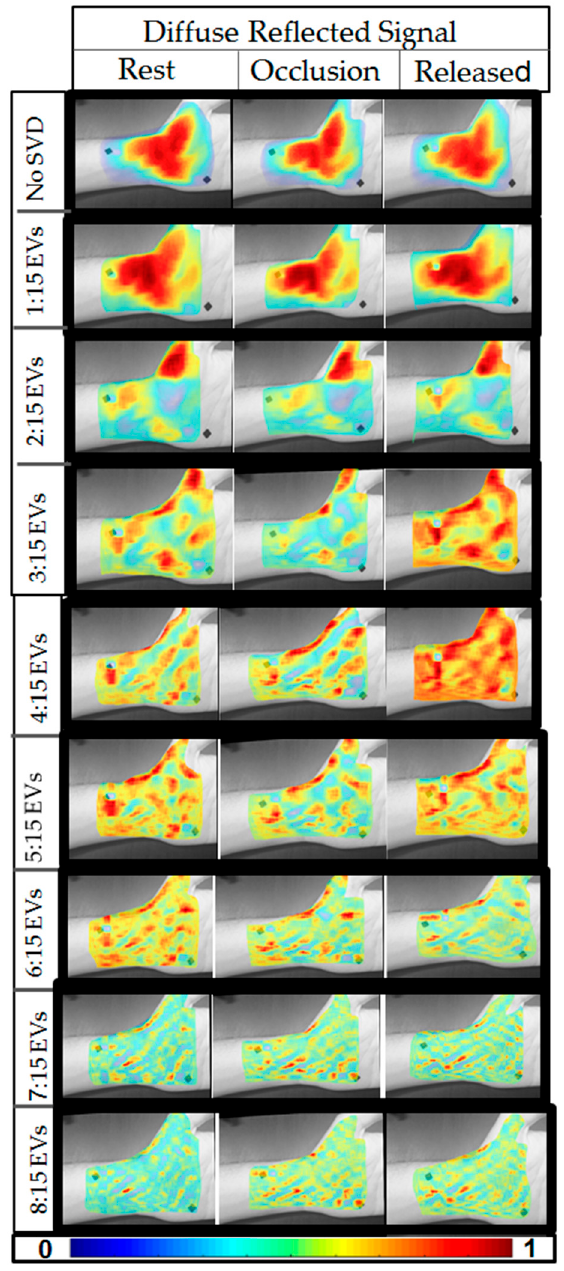
Figure 8. Reconstructed diffuse reflectance images (at 690 nm) across the three time stamps (rest, occlusion, and release) as obtained from the four subjects. The first row shows the coregistered reconstructed images when no SVD was applied. The 2nd–9th rows are coregistered reconstructed images employing SVD and eliminating one lower EV sequentially across the rows.